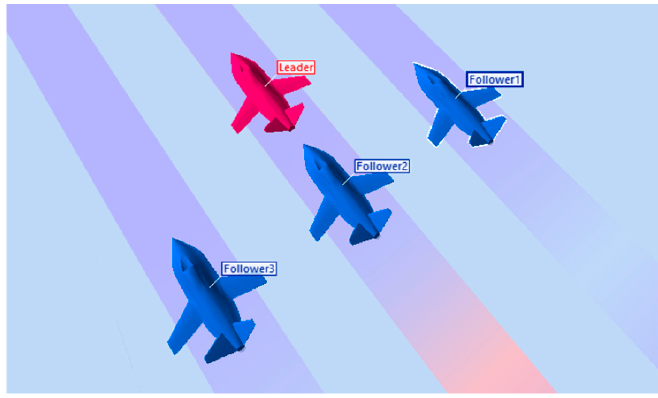
Figure 12. Formation simulation.